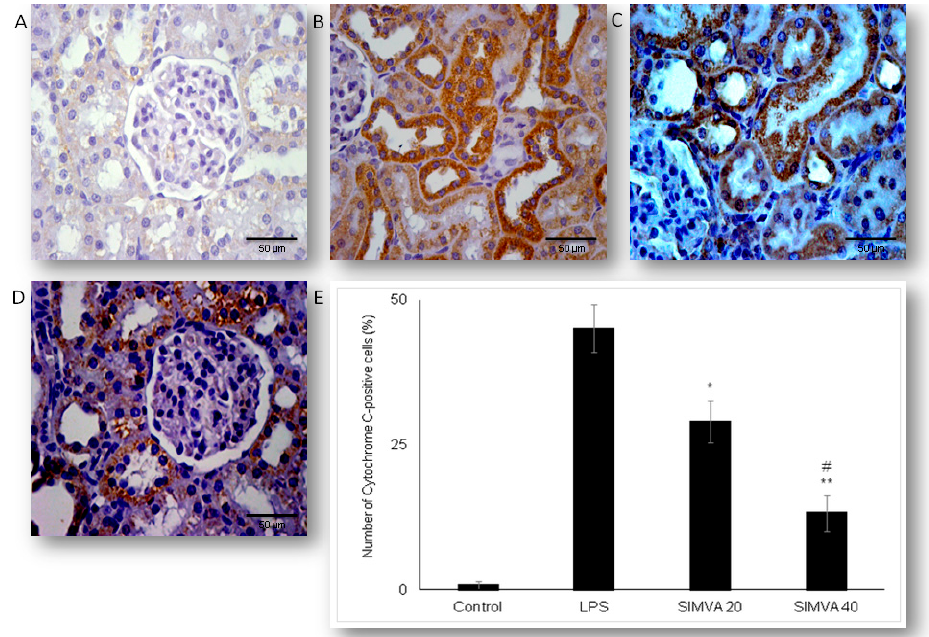
Figure 4. Simvastatin attenuated cytochrome C expression in renal tubular epithelial cells after LPS-administration. The expression of cytochrome C in rat renal tissue examined by